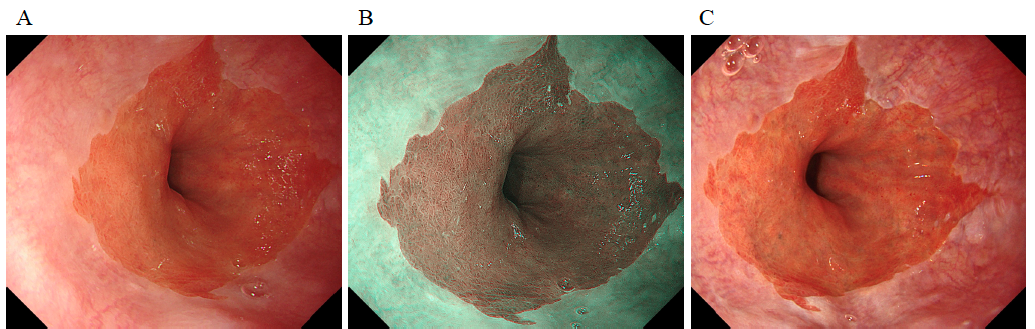
Figure 1. Images taken using a third-generation ultrathin endoscope by white-light imaging ( A ), narrow-band imaging ( B ), and texture and color enhancement imaging ( C